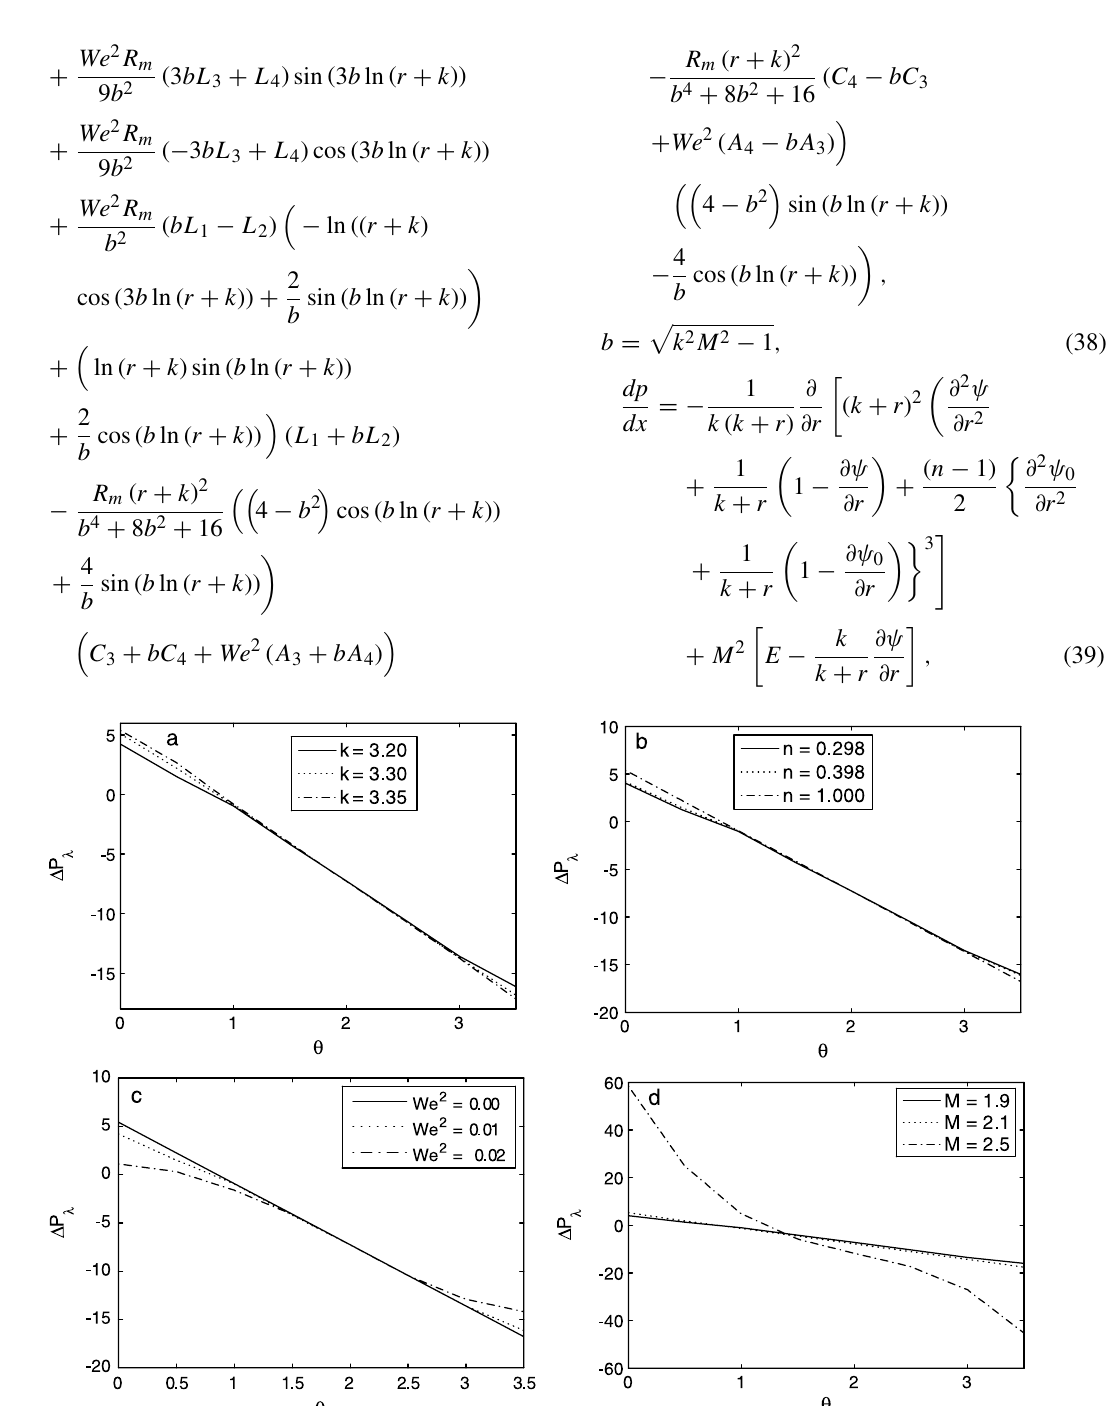
Fig. 2. (a) The pressure rise (cid:17)P λ versus flow rate θ for E = 0 ,n = 0 . 398 ,α = 0 . 4 ,We = 0 . 002 and M =1.9. (b) The pressure rise (cid:17)P λ versus flowrate θ for E = 0 ,k = 3 . 2 ,α = 0 . 6 ,We = 0 . 002 ,M = 1 . 9and k = 3 . 2.(c)Thepressurerise (cid:17)P λ versusflowrate θ for E = 0 ,k = 3 . 2 ,α = 0 . 6 ,n = 0 . 398 ,M = 1 . 9 and k =3.2. (d) The pressure rise (cid:17)P λ versus flow rate θ for E = 0 ,k = 3 . 2 ,α = 0 . 6 ,n = 0 . 298 ,We = 0 . 002 and k = 3 .